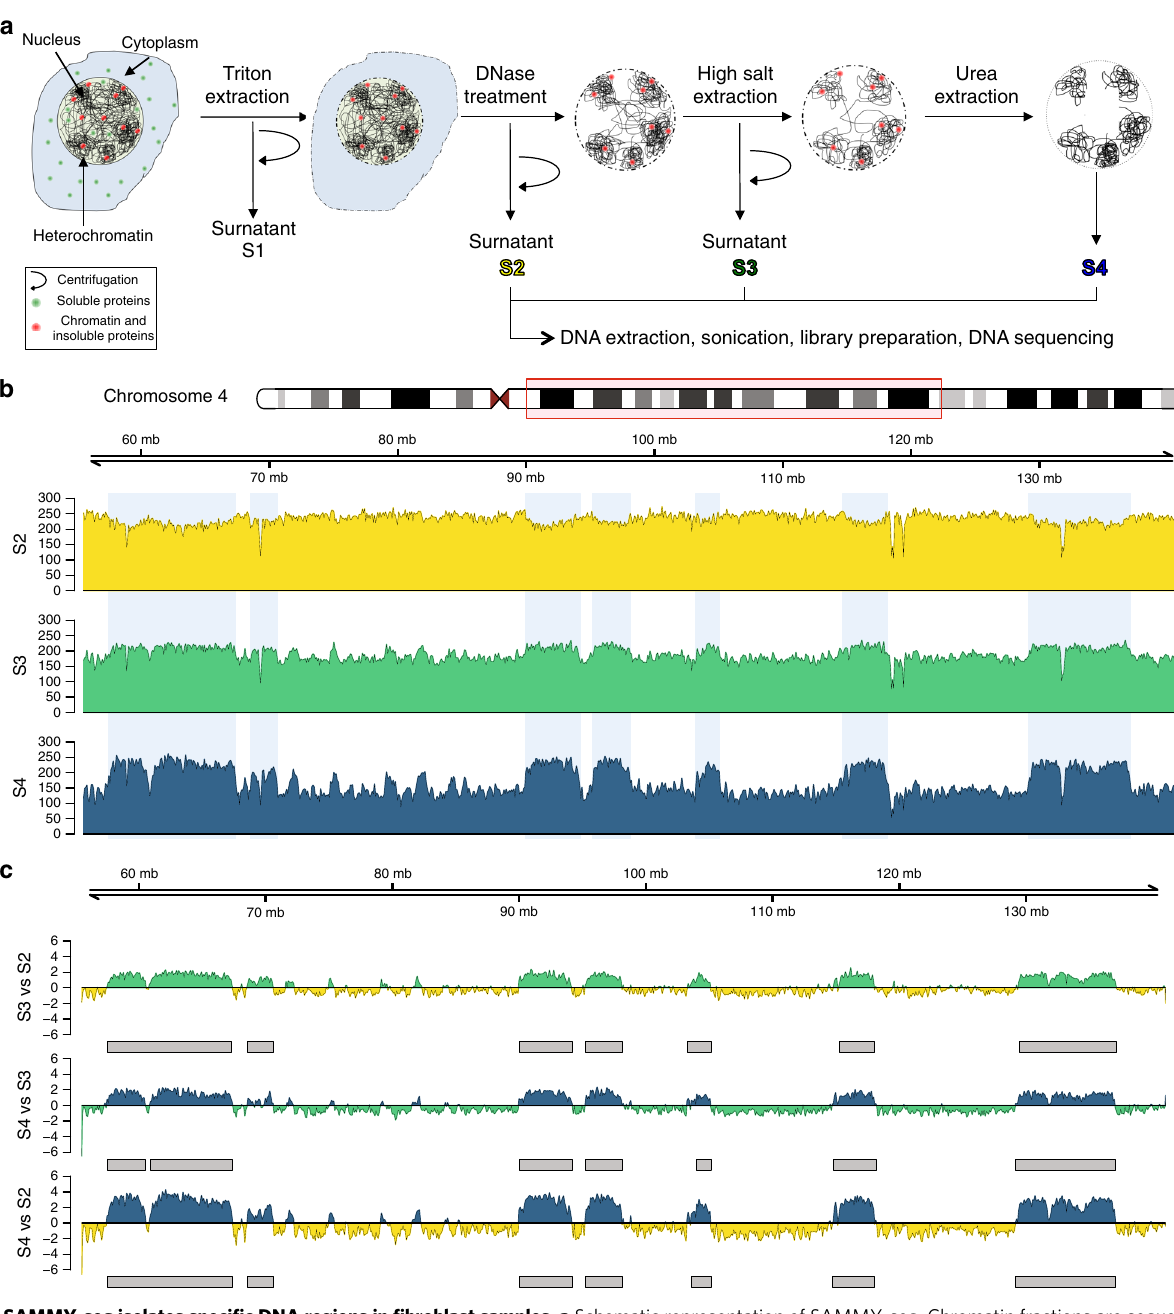
Fig. 1 SAMMY-seq isolates speci fi c DNA regions in fi broblast samples. a Schematic representation of SAMMY-seq. Chromatin fractions are sequentially isolated after DNase treatment, high salt, and urea buffers extractions. The associated genomic DNA is extracted, sonicated, and processed for high- throughput sequencing. b Distribution of SAMMY-seq reads along a representative region (85 Mb region in chr4:55480346-141005766). Library size normalized read counts over 10 kb genomic bins are shown for each sequenced fraction of a control fi broblast sample (CTRL002) at passage 20. c Differential reads distribution across pairwise comparisons of SAMMY-seq fractions in a control fi broblast sample (CTRL002) along the genomic region in b . Less accessible fractions are compared to more accessible ones used as reference (S3 vs S2; S4 vs S3; S4 vs S2). Regions of signal enrichment (green or blue) or depletion (yellow or green) over the reference samples are shown. The smoothed differential signal is calculated with SPP, and signi fi cantly enriched regions (SAMMY-seq domains) are called with EDD and reported as gray boxes under the enrichment signal bins and reaches a plateau for S3 and S4 fractions (Supplementary Fig. 1e). Around 1 Mb resolution, the mean Spearman correlation between control samples is 0.27 for the S2 fraction, 0.92 for S3, and 0.79 for S4. Overall, these results show that S3 and S4 fractions show high similarity whereas the S2 fraction is more variable across biological replicates of control samples (Supple- mentary Fig. 1d).